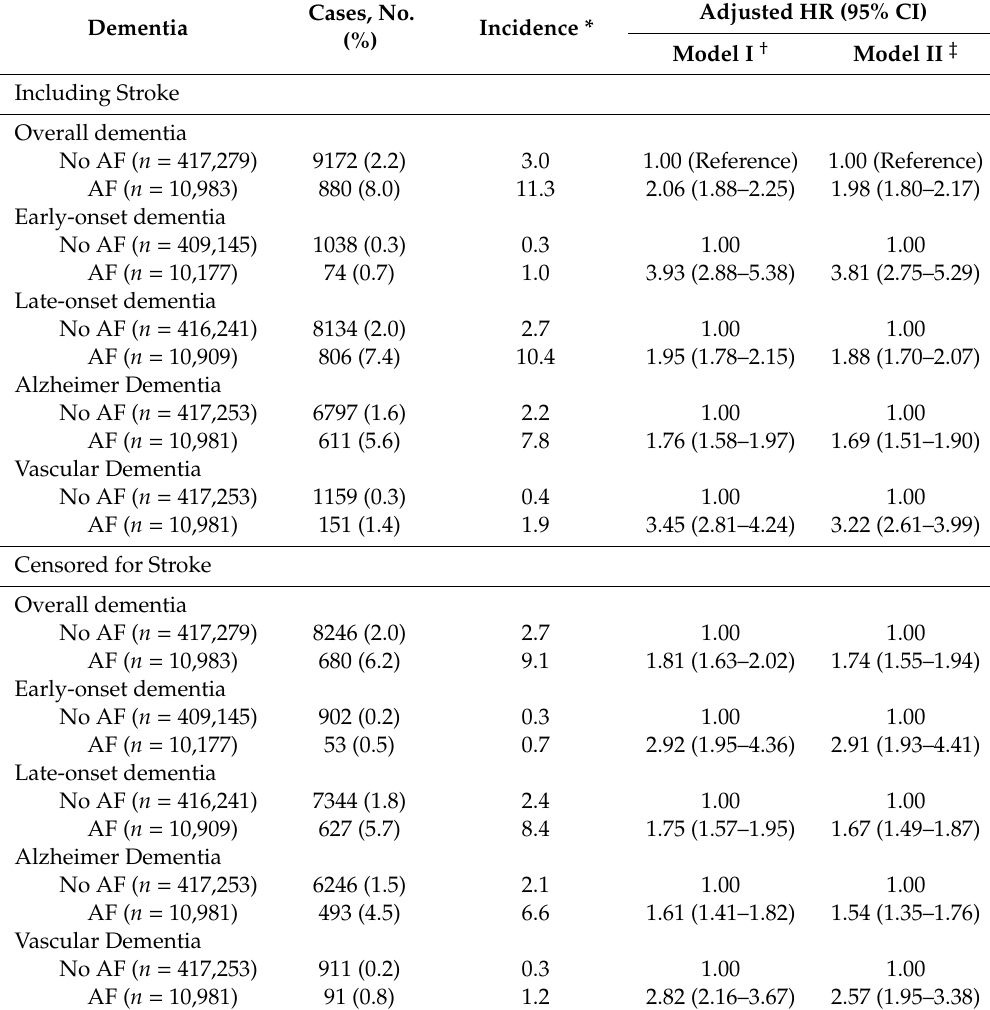
Table 2. Incidence of dementia during follow-up periods according to the AF